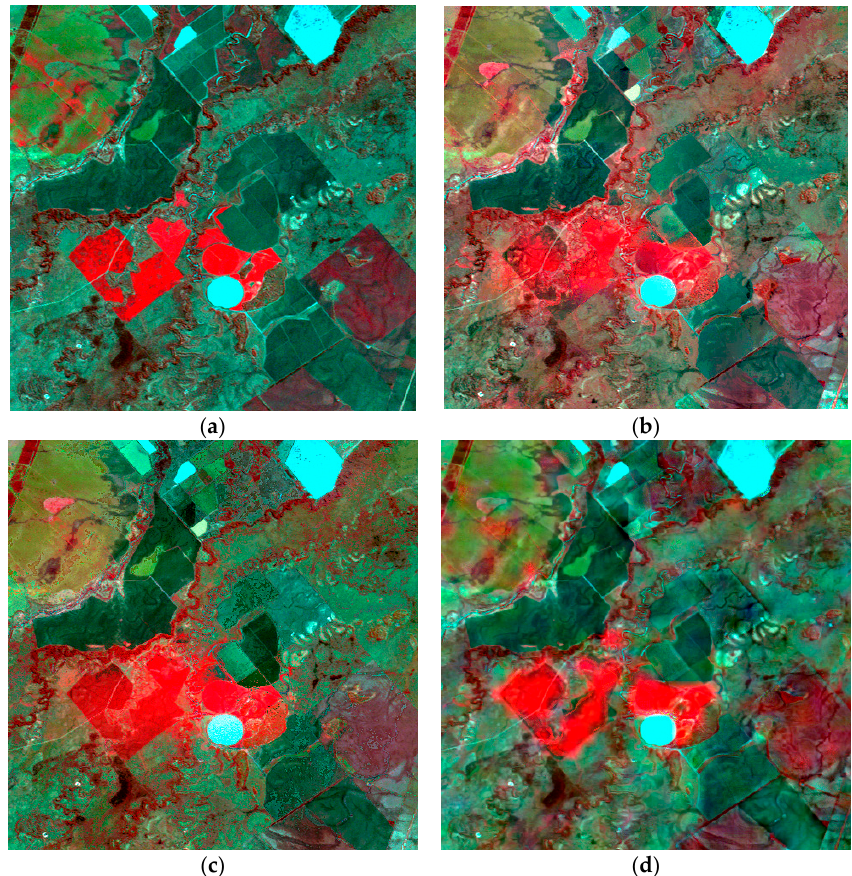
Figure 5. Comparison of the fusion results from the spatial and temporal adaptive reflectance fusion model (STARFM), flexible spatiotemporal data fusion (FSDAF) and RWSTFM methods for the first dataset: NIR-red-green composites of ( a ) the original Landsat image from 5 July 2004; ( b ) the predicted image using the STARFM; ( c ) the predicted image using the FSDAF; and ( d ) the predicted image using the RWSTFM.